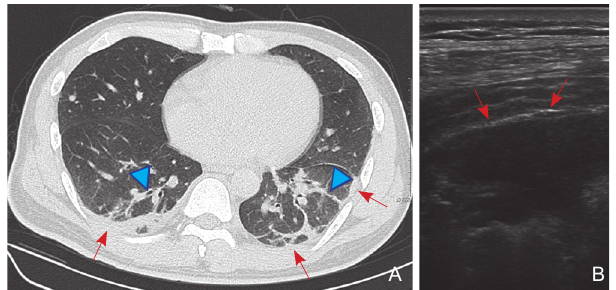
A B Figure 2 This 31-year-old male patient had close contact with COVID-19 pneumonia patient. He had fever for 1 day. (A) Chest CT shows multiple subpleural consolidation (arrows) and interlobular septal thickening (arrowheads) in the bilateral peripheral lung. (B) Lung US using high frequency linear probe in the corresponding location shows tissue-like hypoechoic region (arrows) representing a focal consolidation.